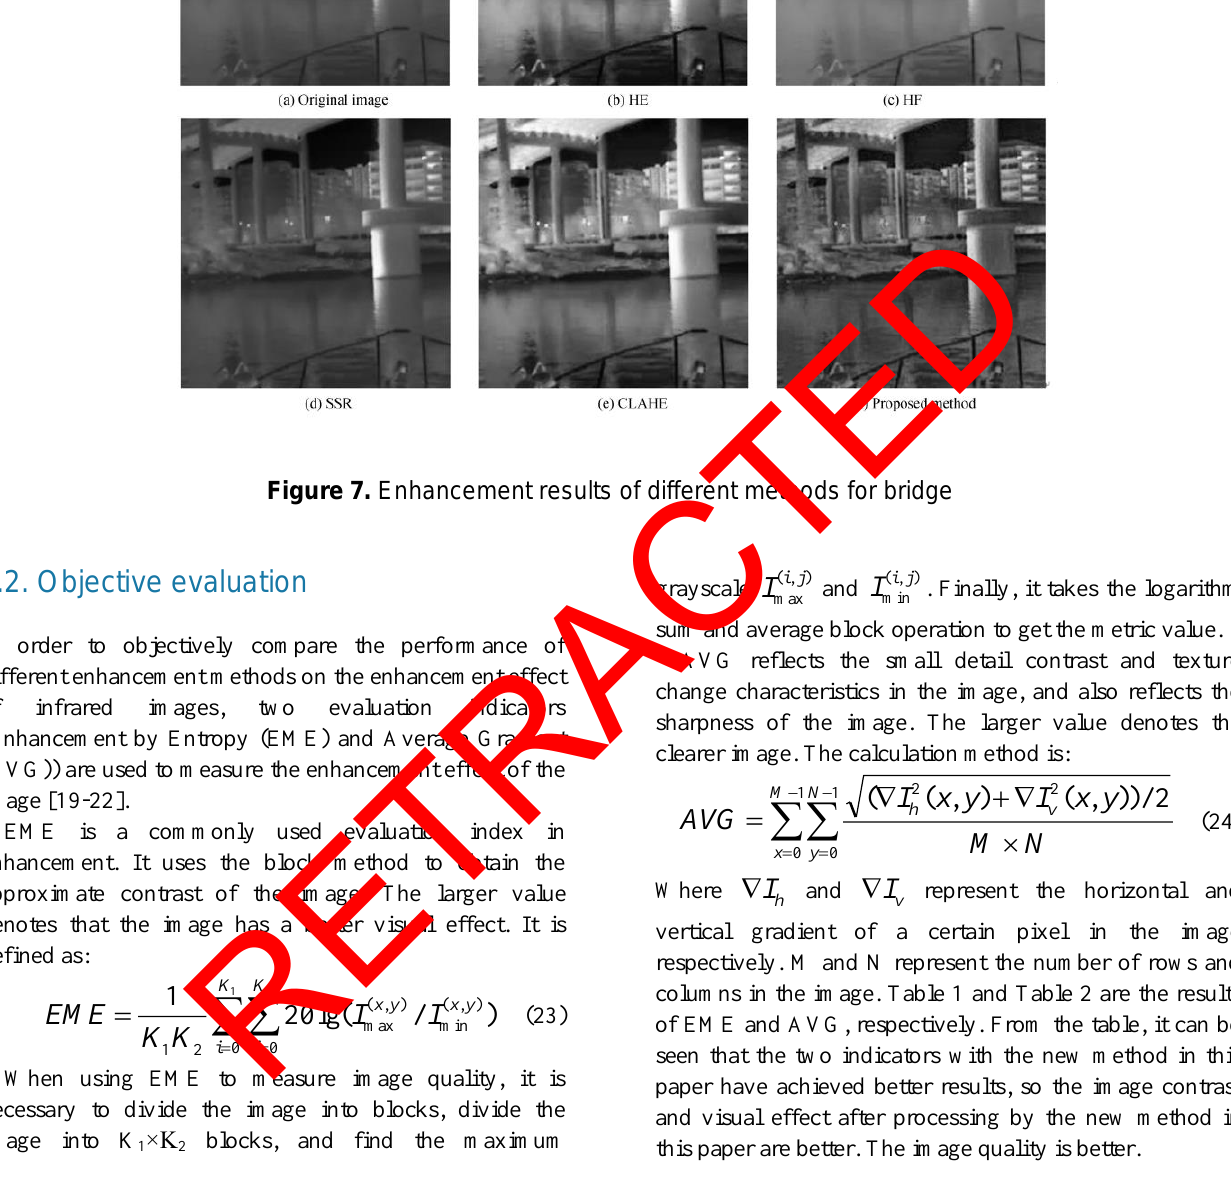
Table 1. EME results with different